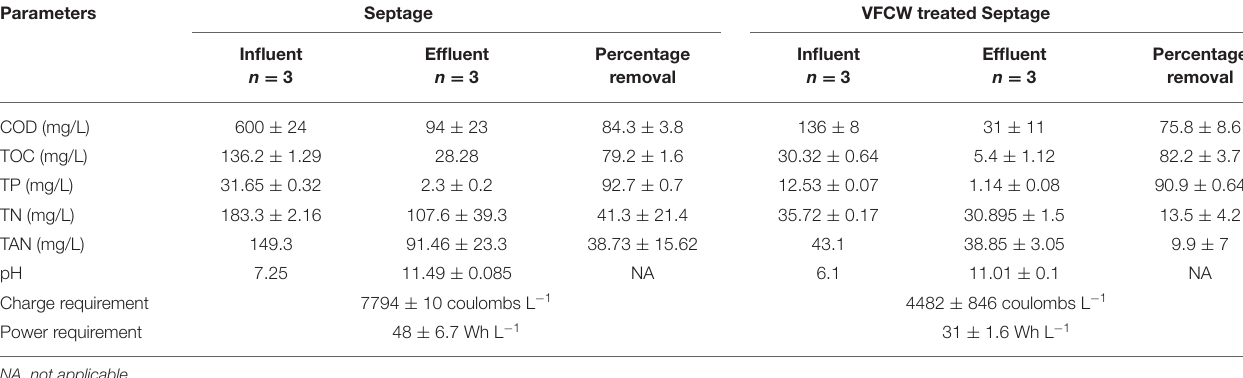
TABLE 2 | Variation of wastewater parameters of the feed in the cathode chamber recirculation of AEM-ECR, feed being septage, and VFCW septage. Parameters